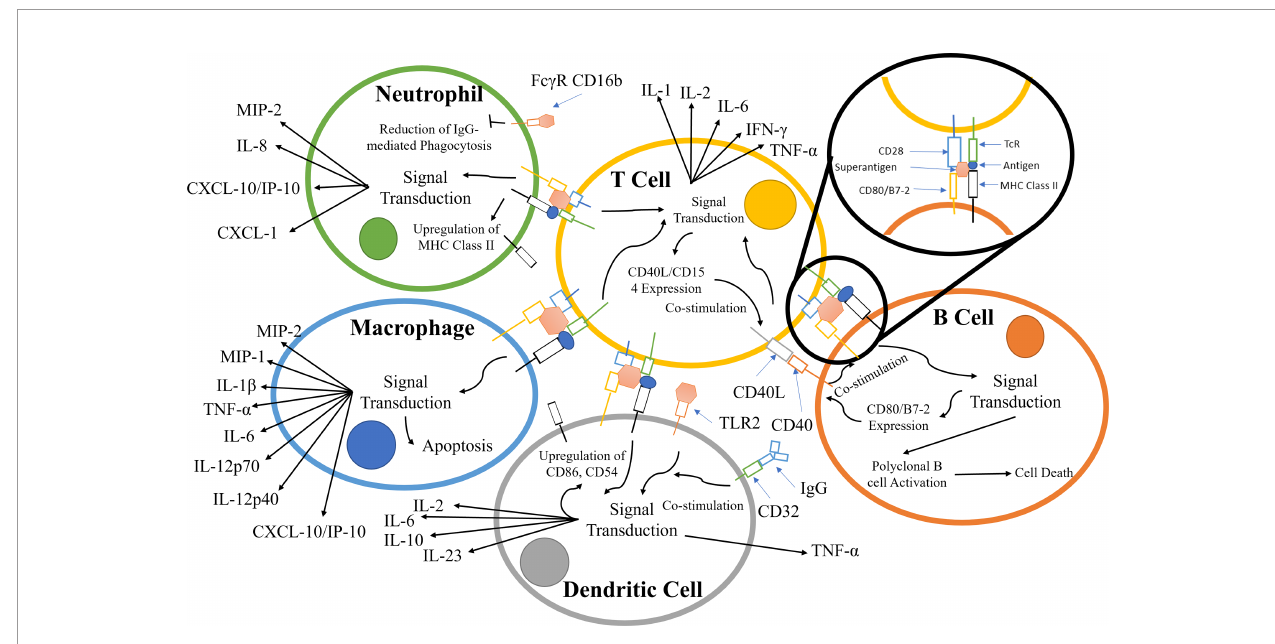
FIGURE 2 | Principal components involved in the superantigen activation of T-cells, B-cells, macrophages, and neutrophils. The interactions displayed are based on material from references (28 – 49). The responses contribute to and escalate the hyper-activation of T-cells and subsequent cytokine